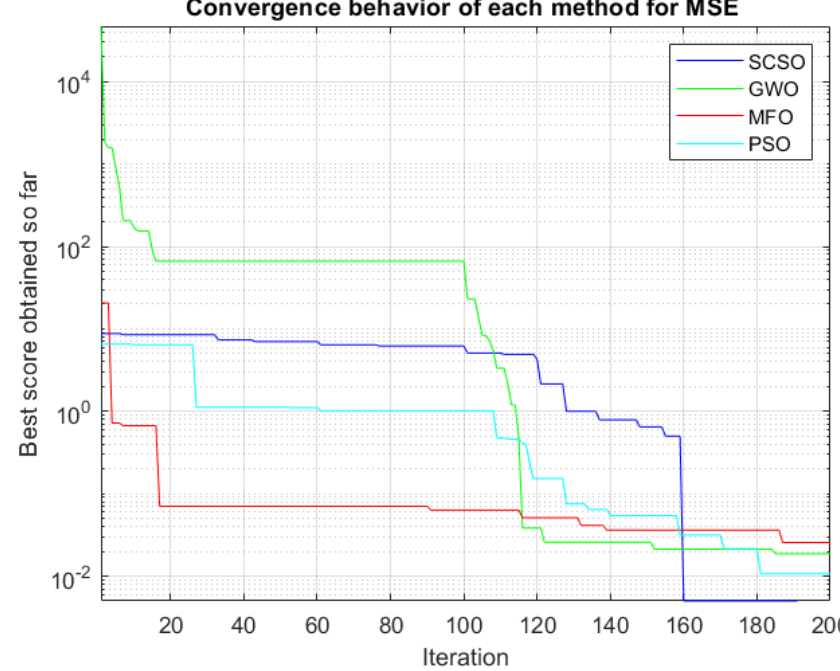
Figure 4. The MSE convergence of each method.